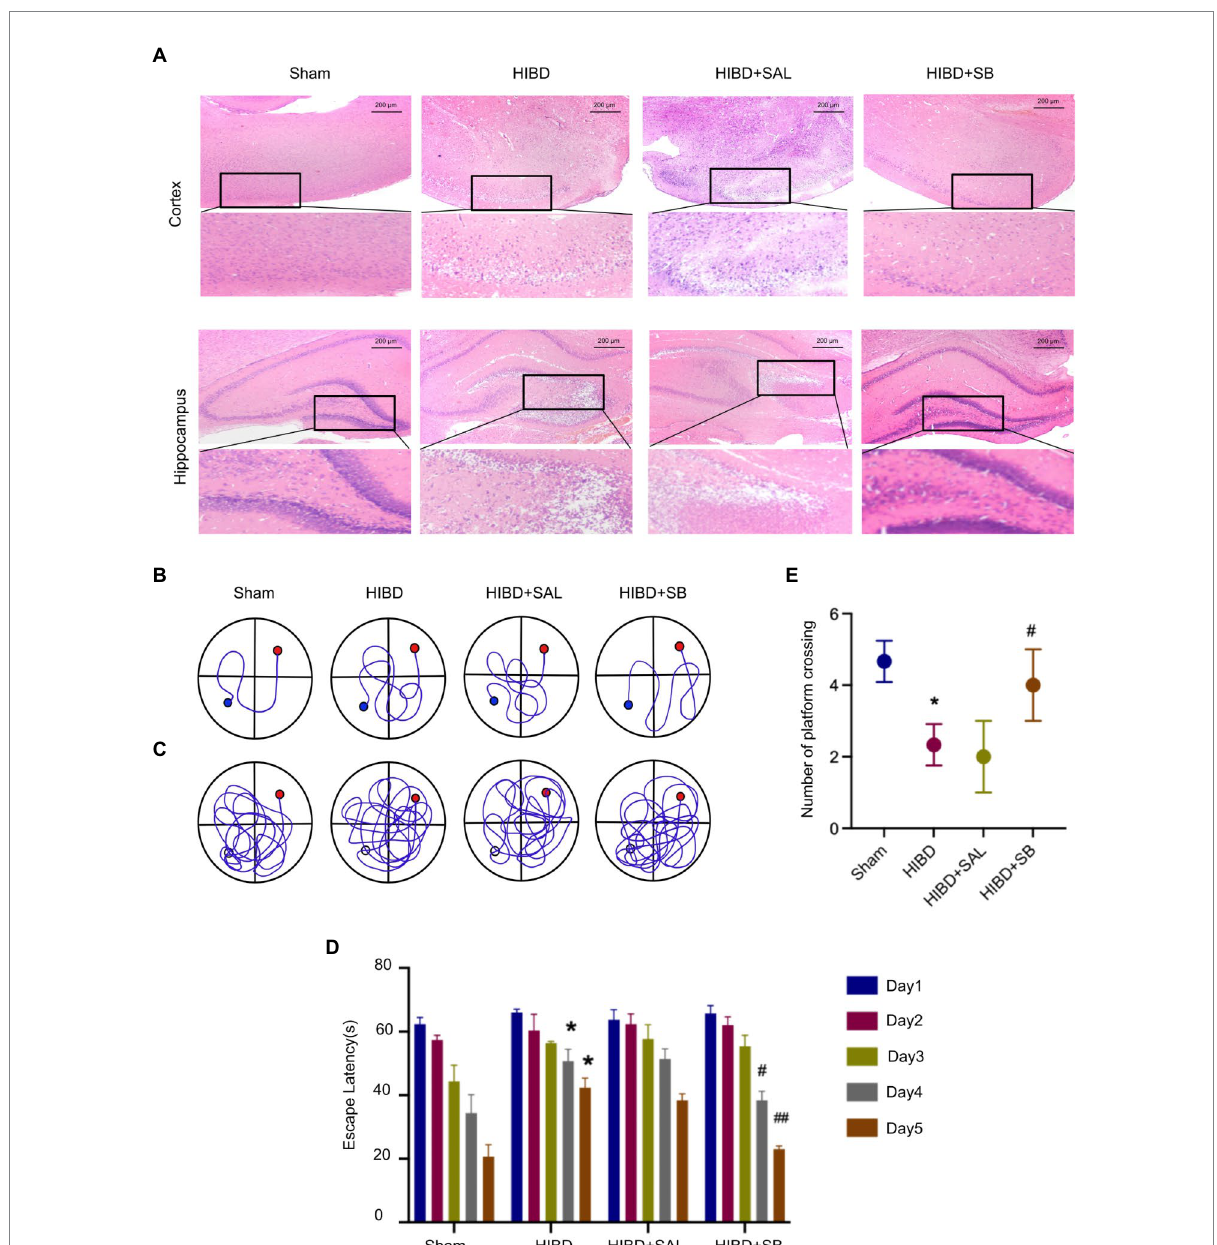
FIGURE 3 ( A ) H&E staining of cerebral cortex and hippocampus tissue pathological changes of rats. ( B–E ) SB ameliorated learning memory deficits in hypoxia-ischemia brain damage Rats: Representative pathways on the fifth day of navigation test ( B ); representative swim paths on the sixth day of test ( C ); Escape latency ( D ); Number of times the rat pups crossed the former location of the platform ( E ); n = 3, error bars represent SD, * < 0.05 compared to Sham group; # < 0.05, ## < 0.01 compared to HIBD